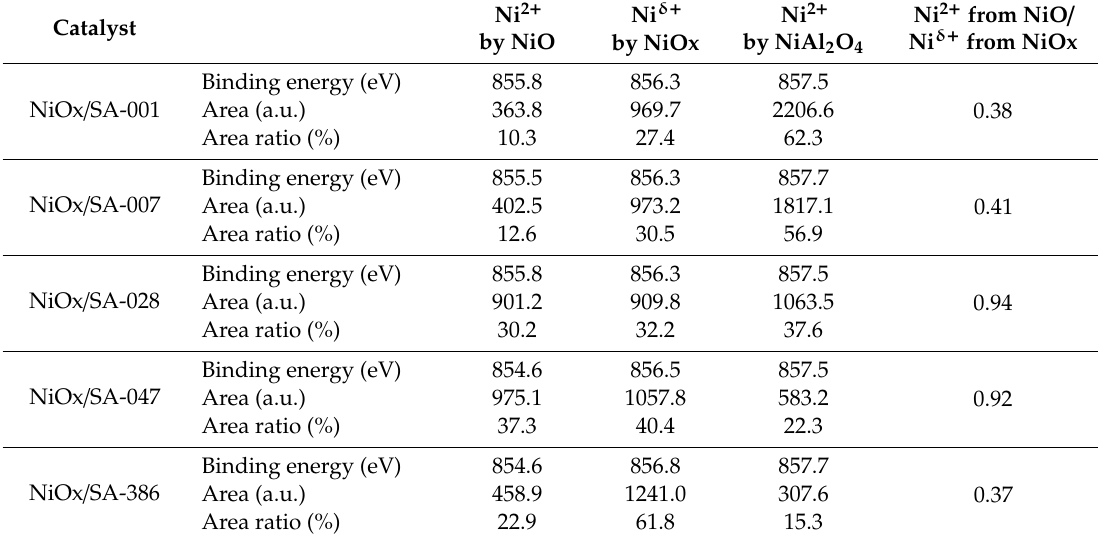
Table 3. Relative intensities of XPS spectra of Ni 2p 3 / 2